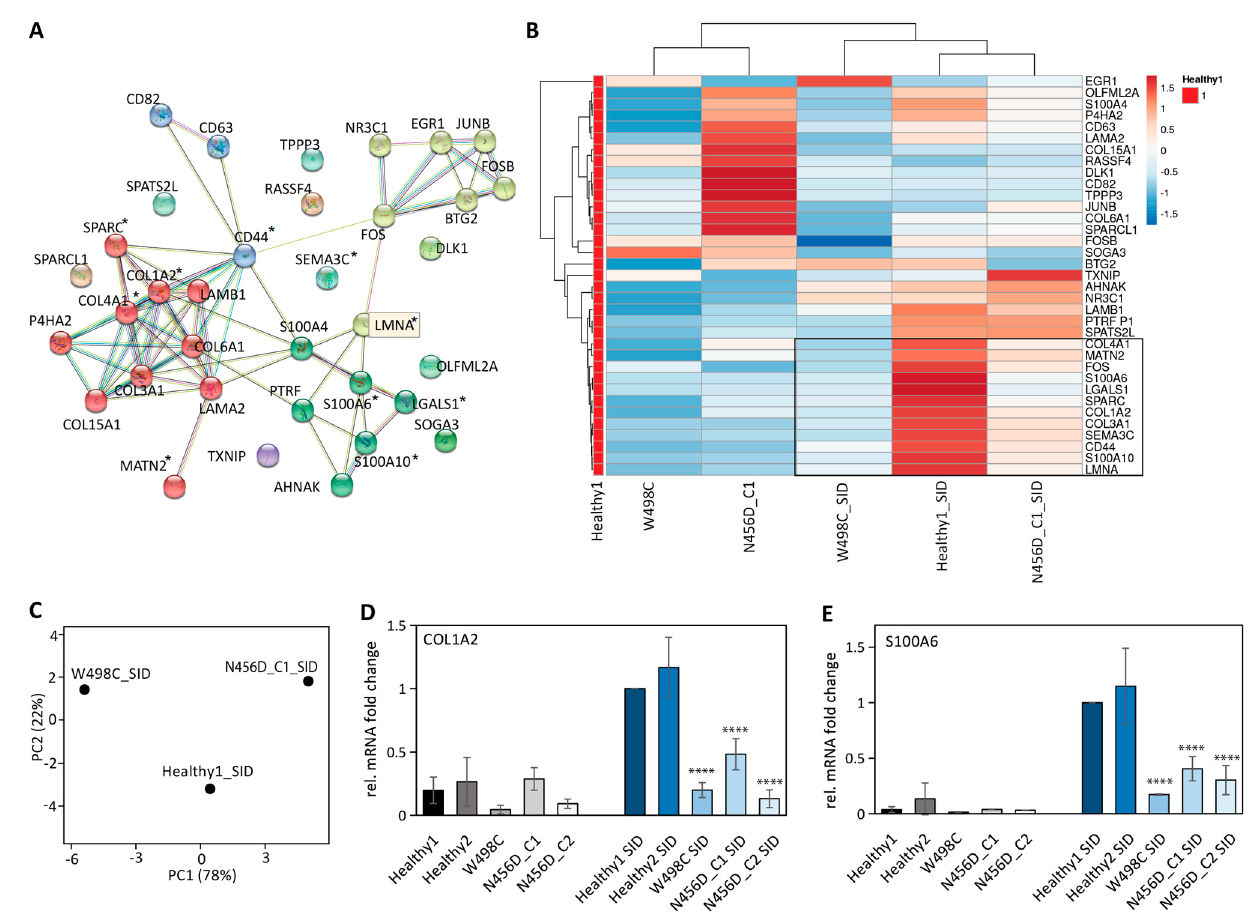
Figure 3. LMNA co-regulated genes prior to and after SID. ( A ) Interaction network of LMNA co-regulated genes during myogenesis (Supplementary Material, Table S2). The network was created via STRING, and proteins are clustered via MCL clustering (minimum required interaction score 0.400). Common genes with impaired expressions after SID in two patient iPSCs were marked with (*). ( B ) Heatmap of gene expression in iPSCs prior to and after SID for LMNA co-regulated genes. All gene expression was normalized to healthy control prior to SID. Gene expressions were clustered using correlation distance and average linkage (raw data in Table S3). Common genes with impaired expressions after SID in two patient iPSCs were marked within the black frame. ( C ) PCA analysis of gene expression file after SID of healthy and patient-derived iPSCs revealed three separated groups. ( D , E ) Selected gene markers among LMNA co-regulated genes for the next step gene editing (N = 3; p < 0.0001, ****). Two healthy controls (healthy1 and healthy2) and two clones from patient carrying N456D mutation (N456D_C1, N456D_C2) were included in validating the selected gene expression. Healthy1 and healthy2: hiPSC LMNA_WT/LMNA_WT ; W498C: patient hiPSCs LMNAc.1494G>T/LMNA_WT ; N456D_C1 or C2: patient hiPSCs LMNAc.1366A>G/LMNA_WT clone 1 or clone